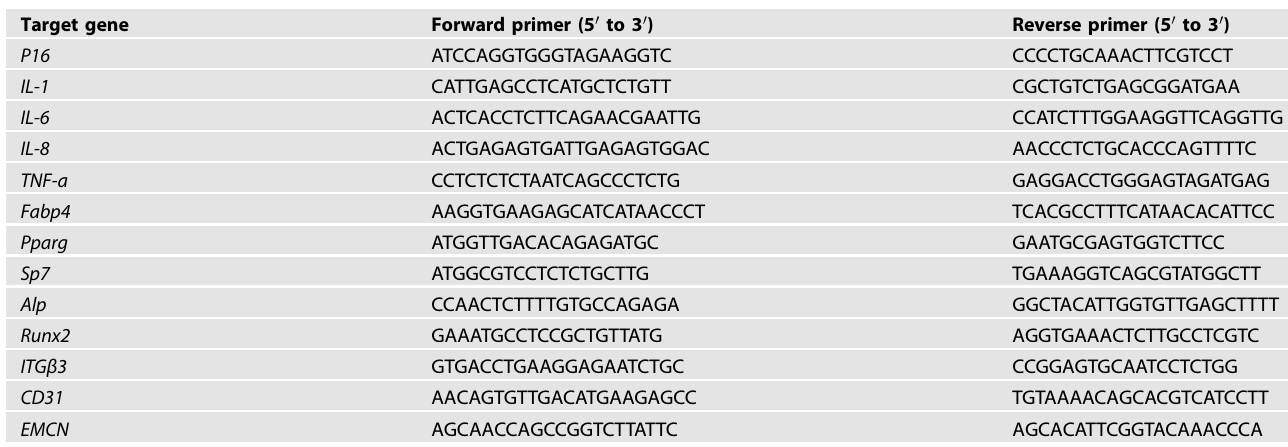
Table 1. List of oligonucleotide primer pairs used in the qRT-PCR analysis. Target